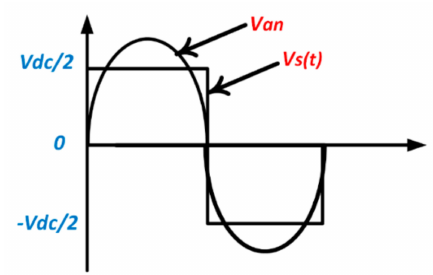
Figure 28. Two-level waveform without PWM [112].